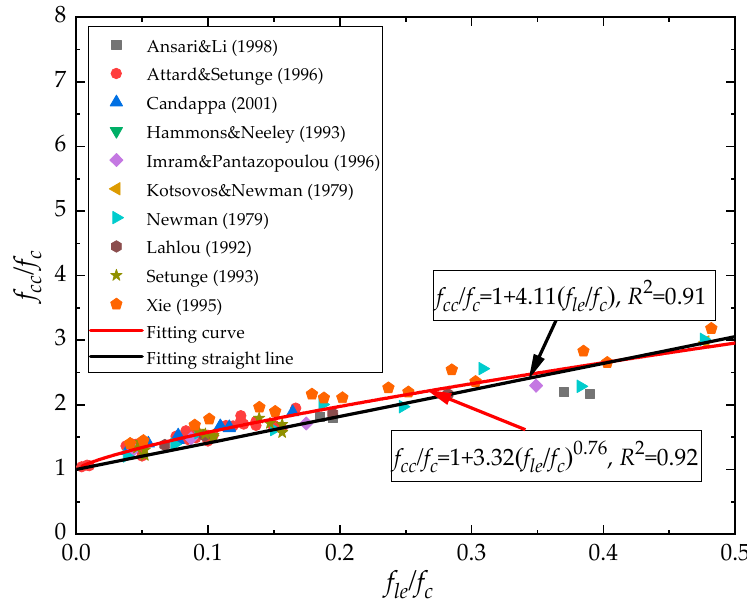
Figure 3. Relationship between 𝑓 (cid:3030)(cid:3030) /𝑓 (cid:3030) and 𝑓 (cid:3039)(cid:3032) /𝑓 (cid:3030) [24–33].